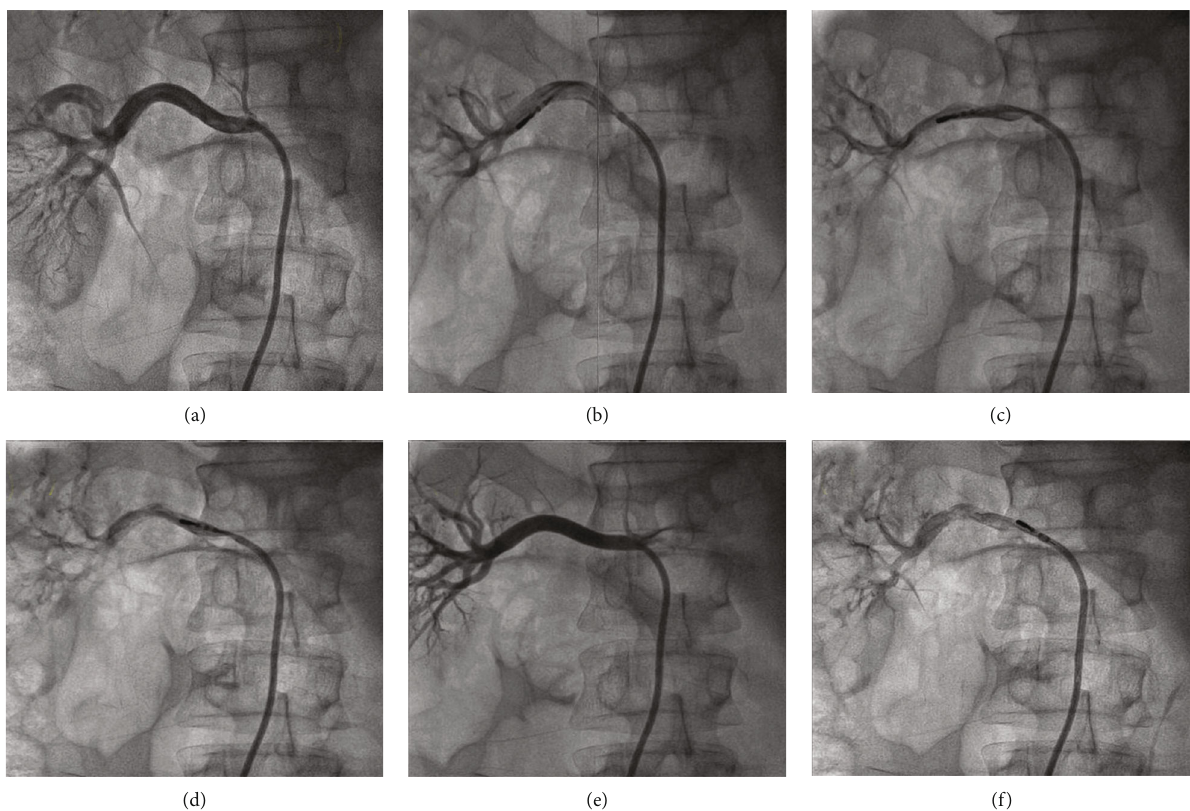
Figure 2: RDN procedure: (a) right renal arteriography before ablation; (b) ablation of lower wall of the right renal artery; (c) ablation of anterior wall of the right renal artery; (d) ablation of posterior wall of the right renal artery; (e) ablation of upper wall of the right renal artery; (f) right renal arteriography after